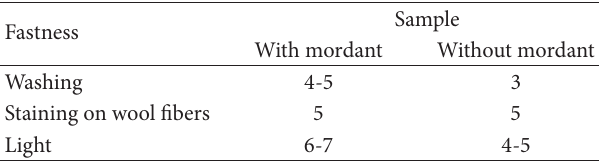
Table 5: Fastness properties of dyed sample with proposed opti- mized condition with and without